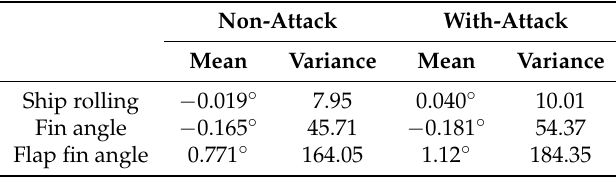
Table 2. Influence of rolling mission by heading signal attack.